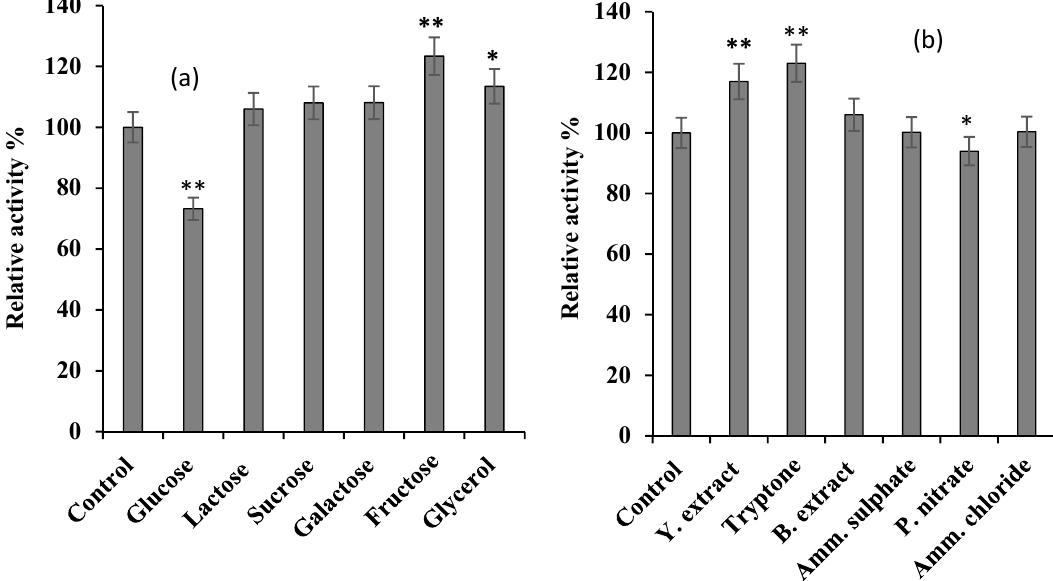
Figure 1. The effect of various carbon ( a ) and nitrogen ( b ) sources on S. griseus recombinant β -glucosidase expression. Recombinant β -glucosidase was expressed by supplementing basal medium with 0.5% (w/v) and 1% (w/v) of different carbon and nitrogen sources, respectively. The control was performed using only basal medium. In each case, cells were grown until OD 600nm reached 0.5, and then induced with 1 mM IPTG for 6 hours at 37 °C, 220 rpm. Enzyme activity of crude lysate was performed using 7mM p NPG as the substrate in 50 mM potassium phosphate buffer, pH 7 (see Section 2.2.2). The data plotted represent the mean of three independent experiments, with standard deviation shown as error bars: * p -value ≤ 0.05, ** p -value ≤ 0.01 represent a significant and a very significant difference, respectively, based on two-tailed t- test and in comparison to the control.